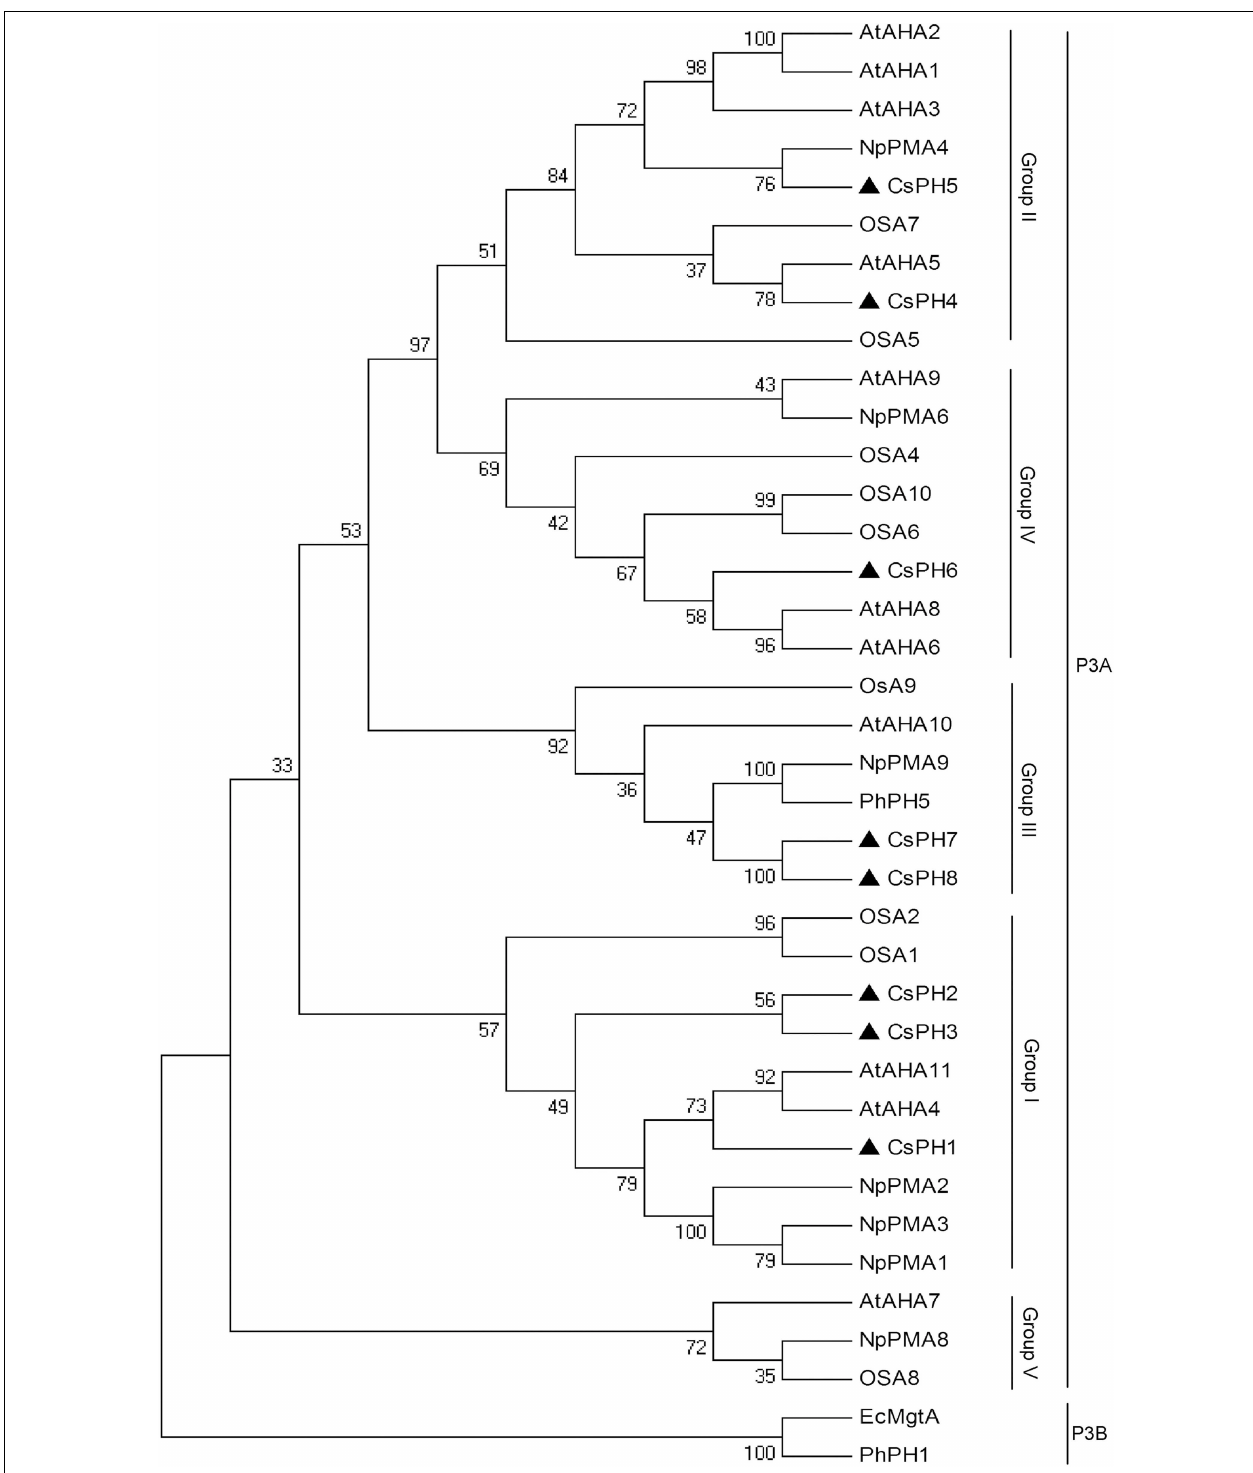
gene accession numbers are listed in Table S6. The numbers at the branch points indicate bootstrap support (1000 replicates). The black triangle shows the position of eight CsPH isoforms. The EcMgtA and PhPH1 belonging to P 3B -ATPases were used here as